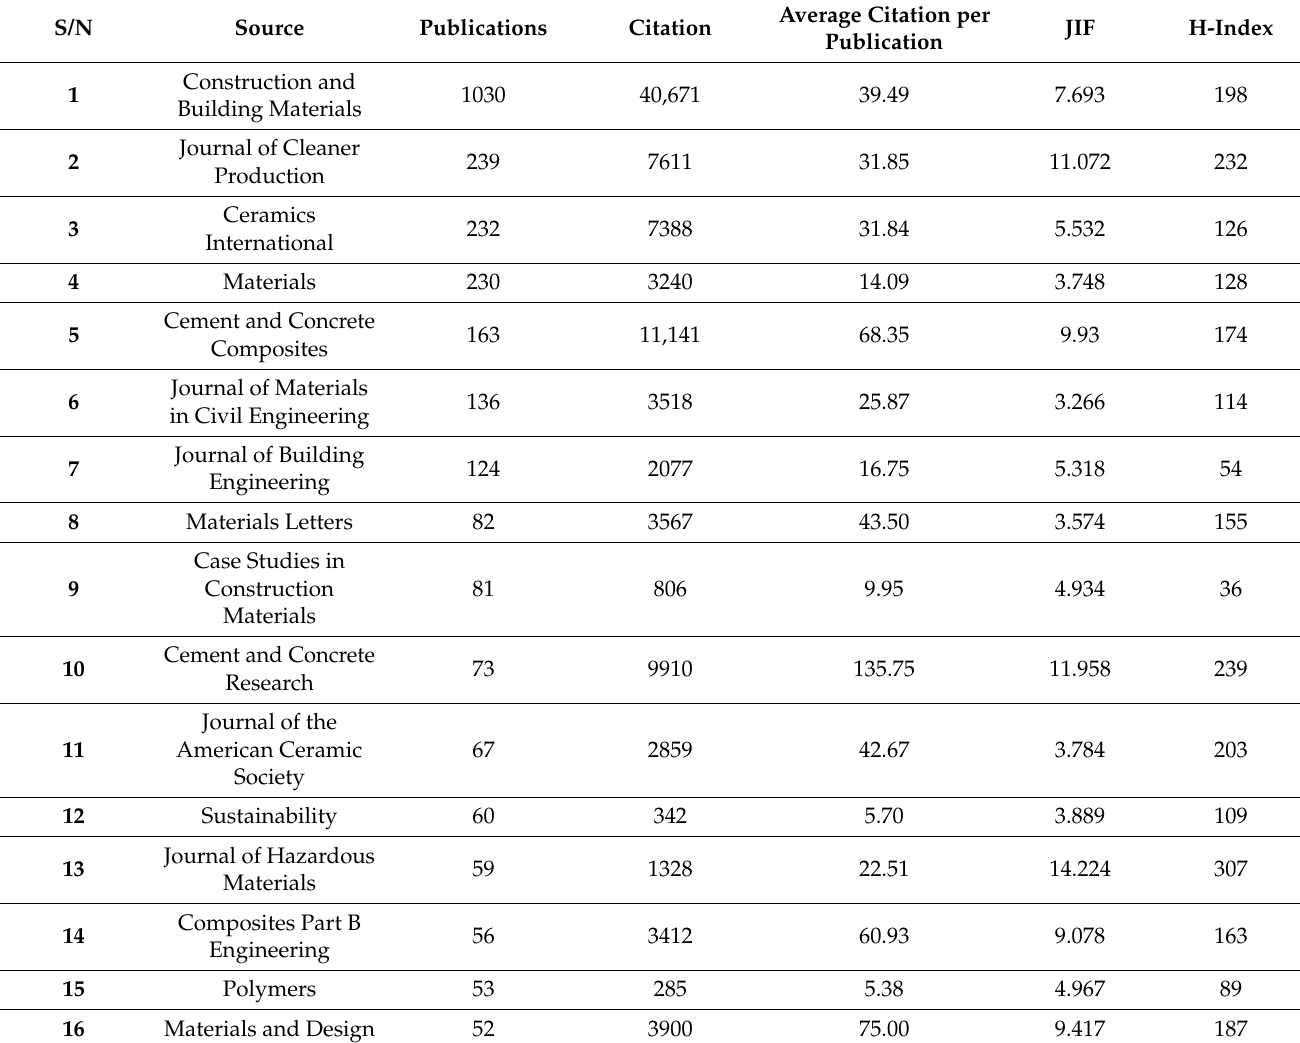
Table 3. Publication sources with a minimum of 50 documents from April 2011 to April